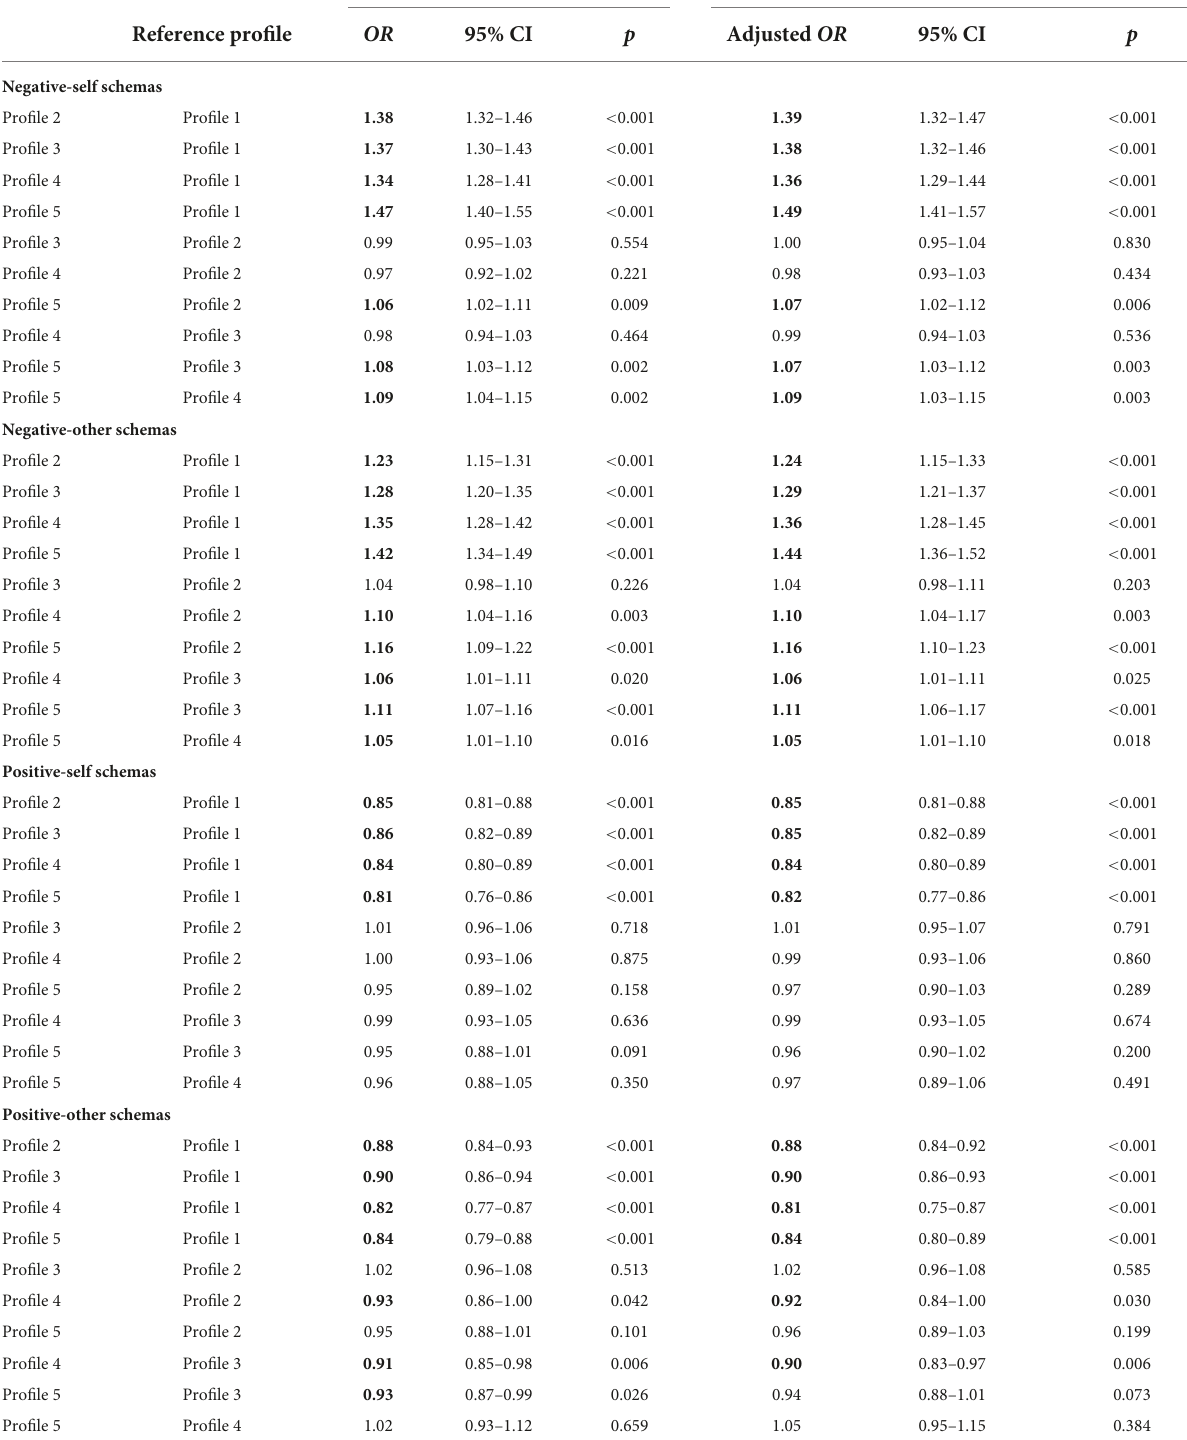
TABLE 4 Multinomial logistic regression of latent profiles using Vermunt’s 3-step